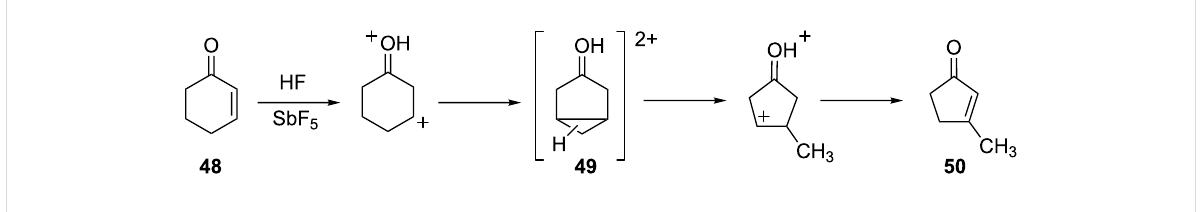
Scheme 11: Isomerization of 2-cyclohexen-1-one ( 48 ).